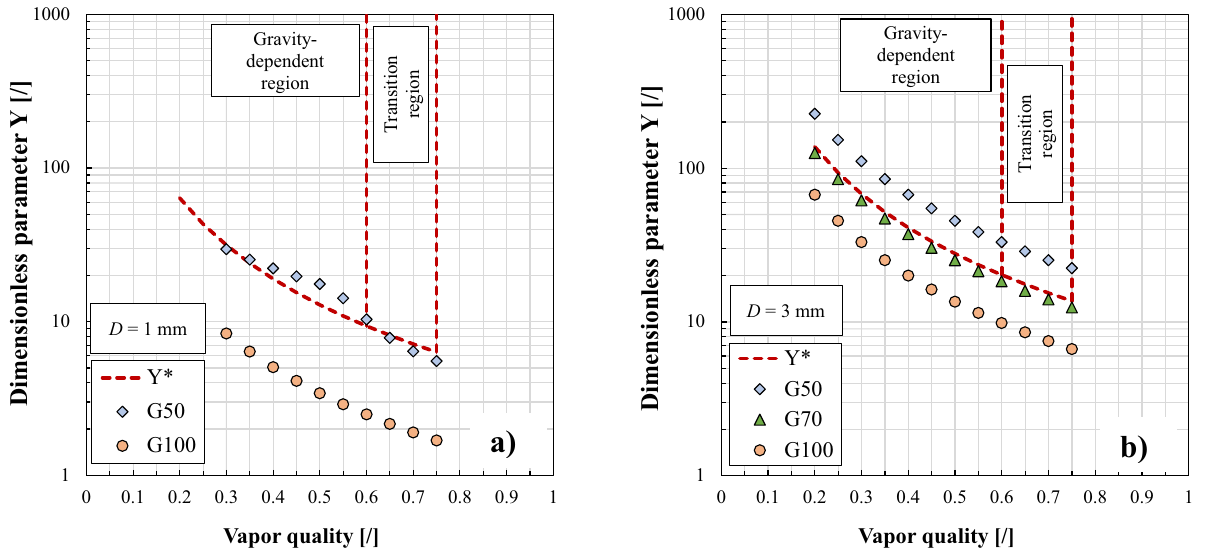
Fig. 6 Range of mass fl uxes showing an effect of inclination during in-tube condensation. Dimensionless inclination parameter reported versus vapor quality for HFE-7000 at 47 °C saturation temperature inside ( a ) a 1 mm inner diameter minichannel and ( b ) a 3 mm inner diameter tube (Azzolin et al. 27